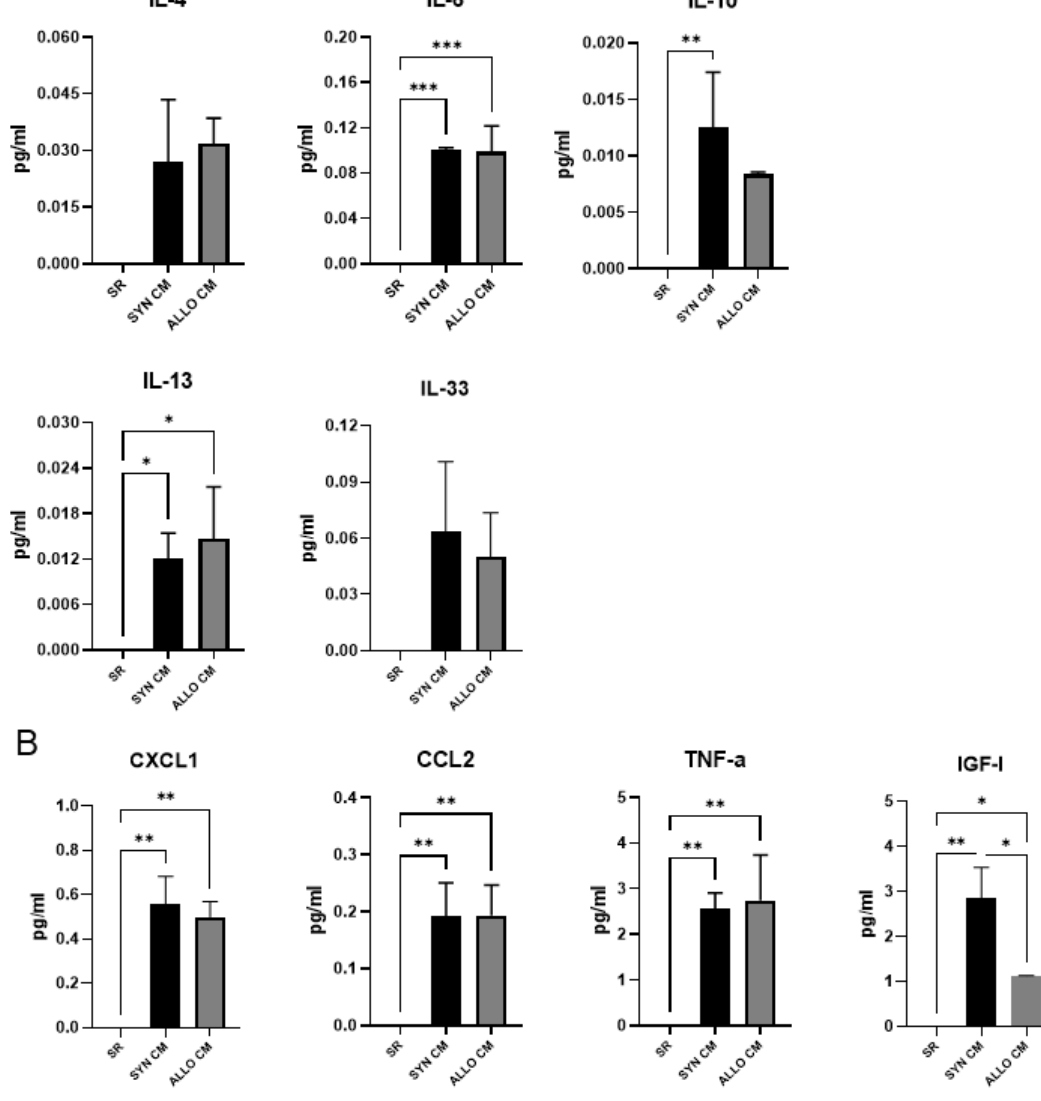
Figure 1. Luminex assay analysis of medium conditioned with SYN or ALLO BMSCs. Concentration of IL-4, IL-6, IL-10, IL-13, IL-33, CXCL1, CCL2, TNF- α , IGF-I in chemically defined medium and chemically defined medium conditioned for 48 h by BMSCs (CM). ( A ) Factors detected at low concentrations; ( B ) Factors detected at high concentrations. Data are presented as means of three independent experiments with standard deviations. Data found to be statistically significant are underlined on graphs and marked with asterisks (* p < 0.05; ** p < 0.01; *** p < 0.001).